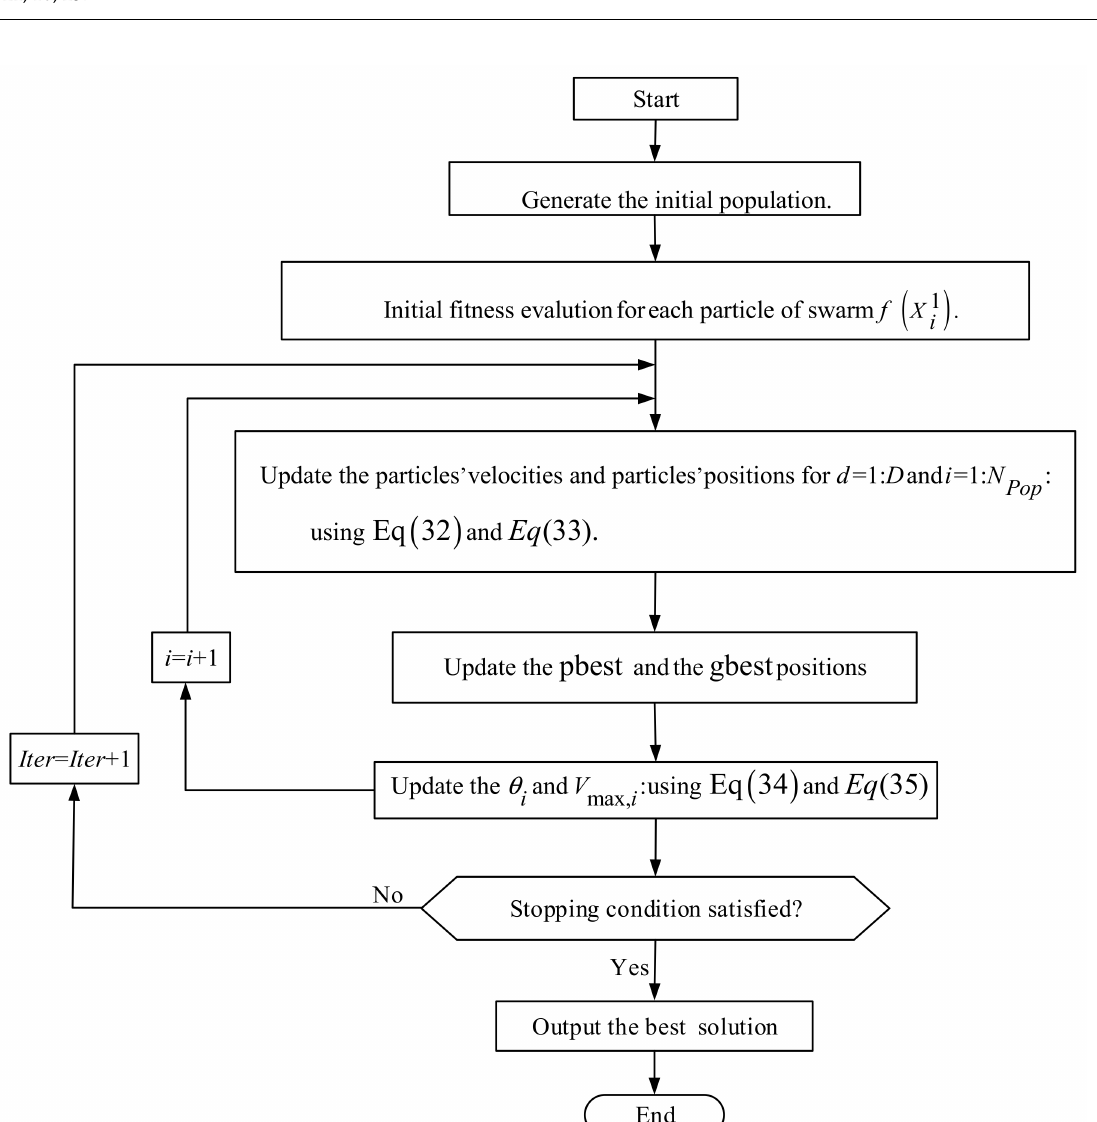
Figure 2. Flowchart of the proposed phasor particle swarm optimization (PPSO) algorithm